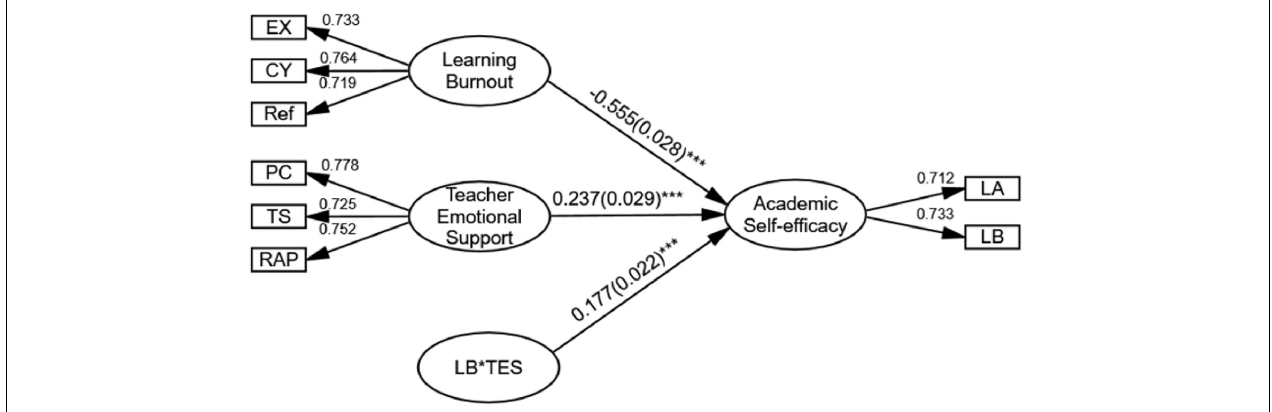
FIGURE 3 | The path model for the relationship amongst teacher emotional support, university students’ English online learning burnout, and academic self-efficacy. EX, exhaustion; CY, cynicism; Ref, reduced efficacy; PC, positive climate; TS, teacher sensitivity; RAP, regard for adolescent perspective; LA, learning ability; LB, learning behaviour. *** P < 0.001.